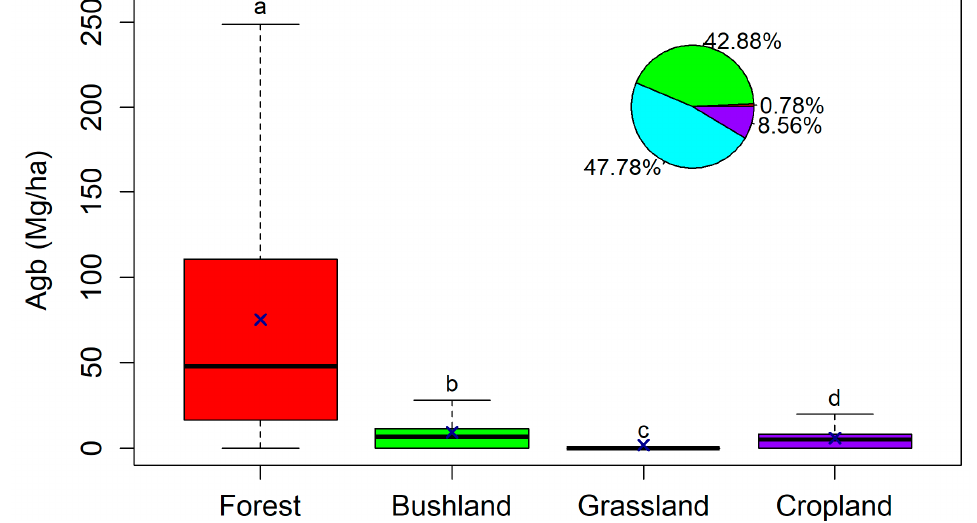
Figure 6. Aboveground biomass (AGB) distribution for the land cover types based on the AGB map. The pie chart shows the distributions of the types in the study area. Letters indicate significant differences (p < 0.05) according to the Dunn test. The outliers in each box plot are not shown. The “x” on each box plot represents the means and the whiskers represent confidence intervals.